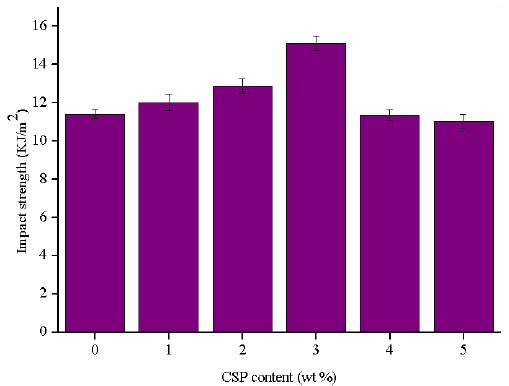
Figure 6. Impact strength of the epoxy thermosets modified with different contents of CSPs.